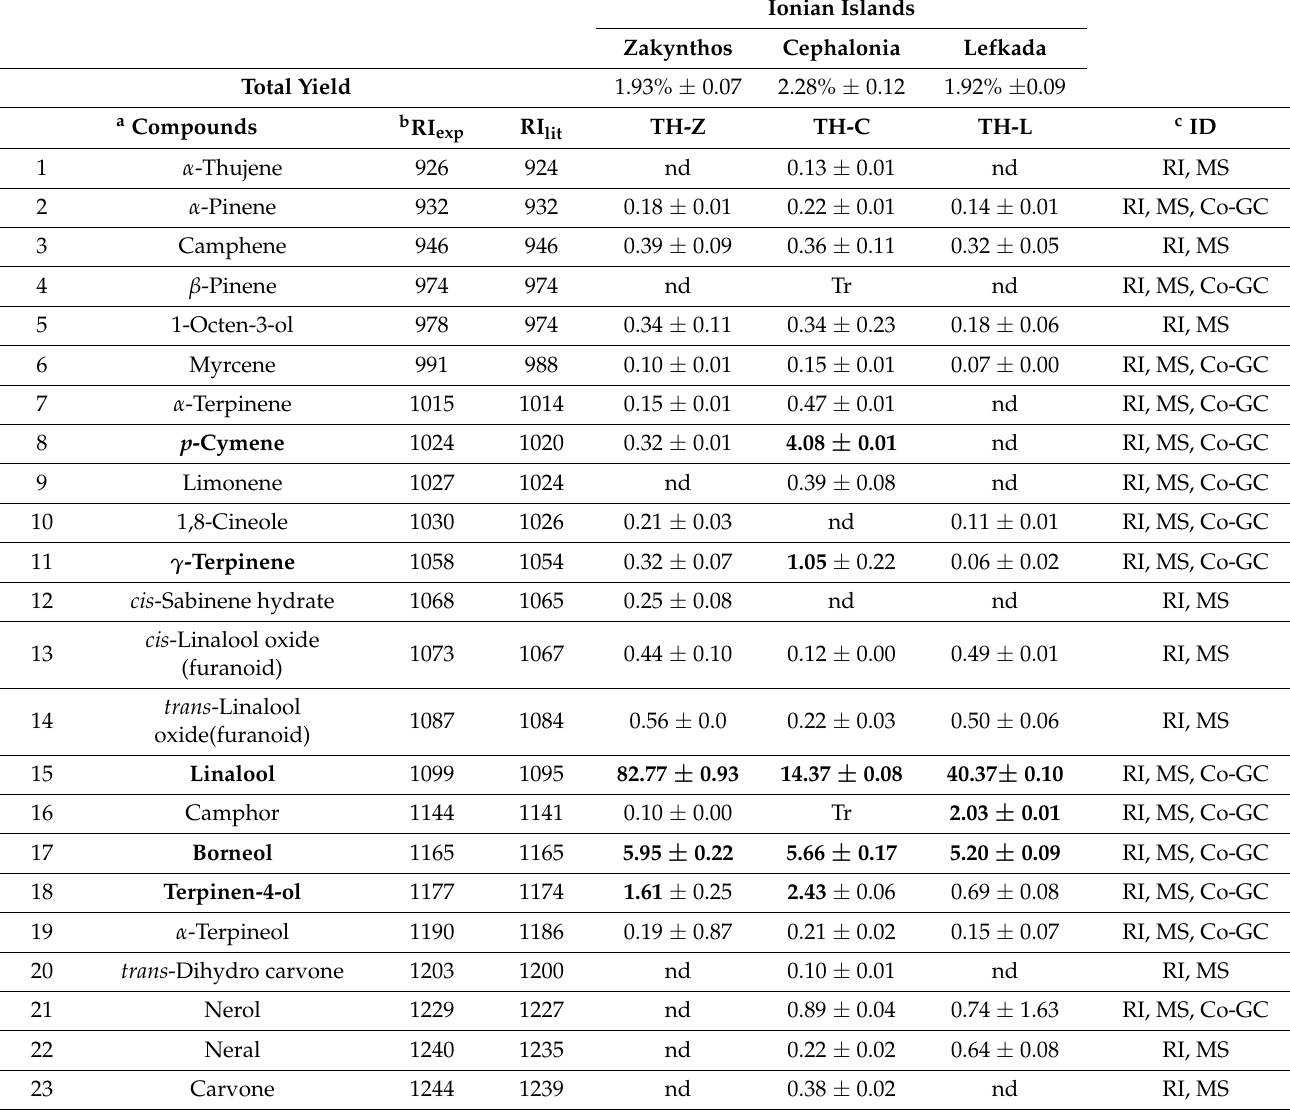
Table 1. Composition of the essential oils of Thymus holosericeus collected from three Ionian Islands, Greece (TH-Z: Zakynthos; TH-C: Cephalonia, TH-L: Lefkada) during full-flowering (July 2018). The dominant compounds at least in one sample are marked in bold. Ionian Islands Zakynthos Cephalonia Lefkada Total Yield 1.93% ± 0.07 2.28% ±